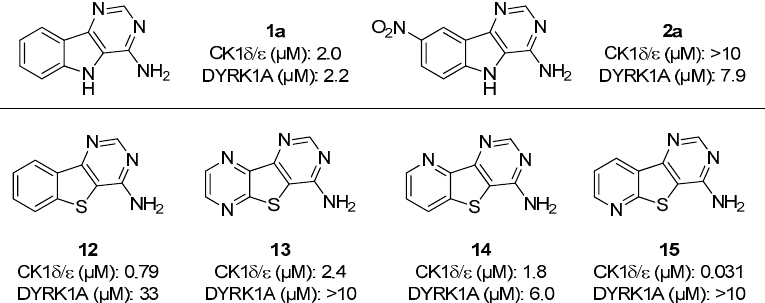
Figure 2. Comparison between selected pyrimido[4,5- b or 5,4- b ]indol-4-amines described in this work and some of their thieno[2,3- d ]pyrimidin-4-amine congeners ( 12 , 13 , 14 and 15 ) described in preceding work.